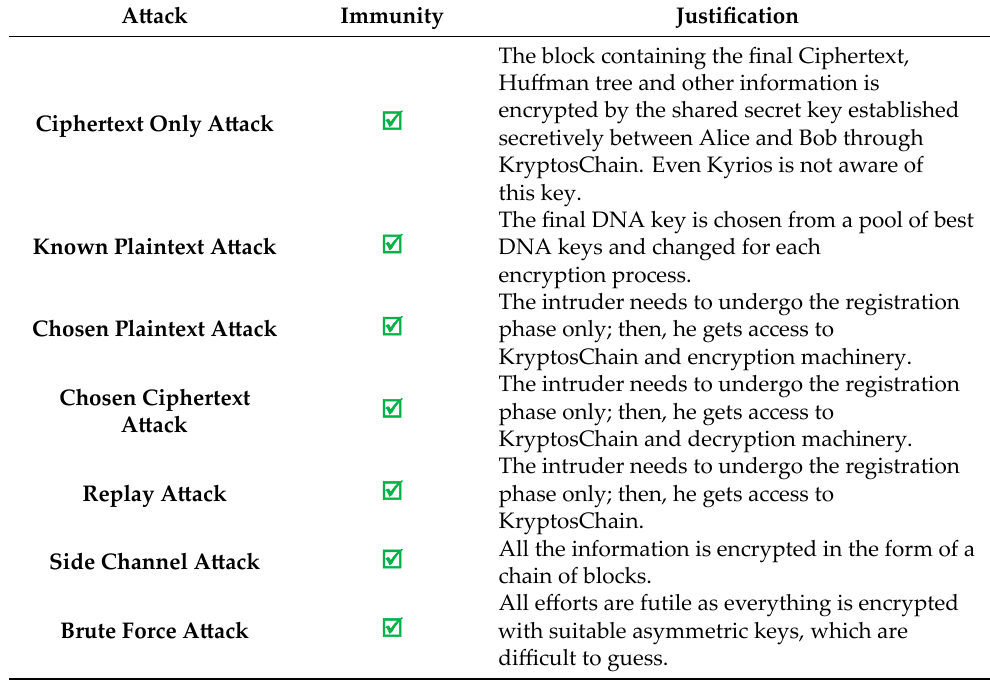
Table 14. Attainment of Immunity to Cryptographic Attacks by Proposed Cipher Transmission Scheme.